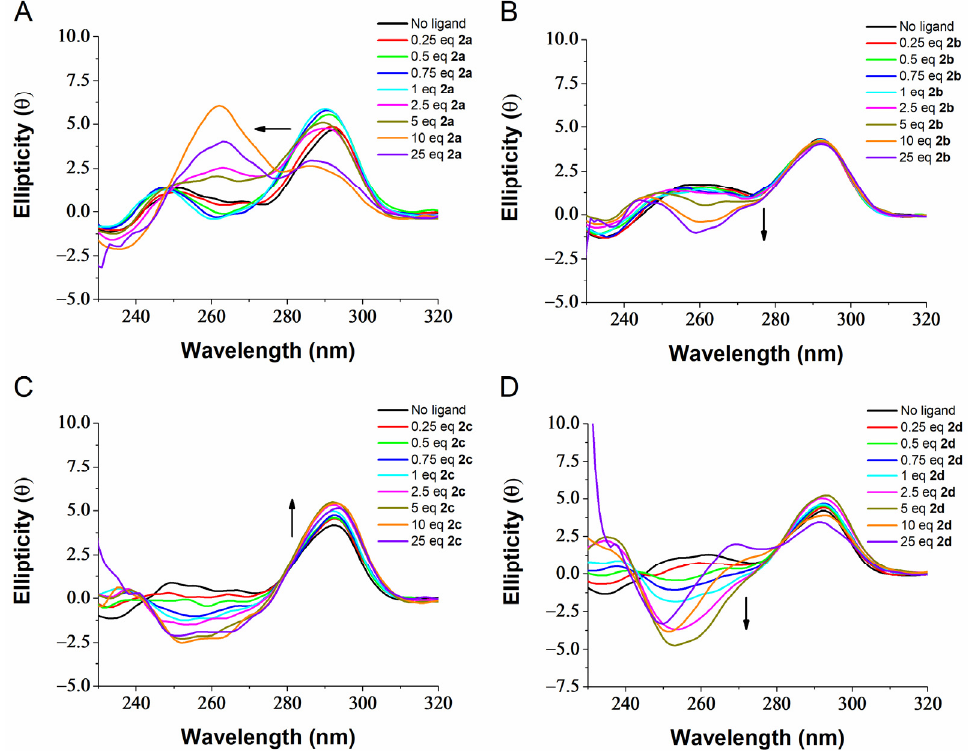
Figure 2. CD titration of h-Telo in presence of increasing equivalents (0–25) of compound 2a ( A ), 2b ( B ), 2c ( C ), 2d ( D ), at a concentration of 10 μ M, performed in 20 mM lithium cacodylate containing 10 mM KCl and 90 mM LiCl.